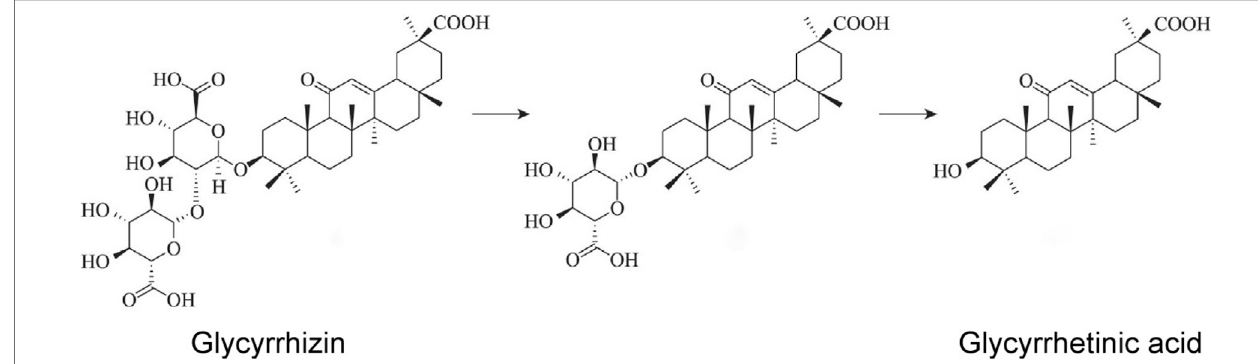
FIGURE 1 | The structure and metabolic relationship between glycyrrhizin and glycyrrhetinic acid.